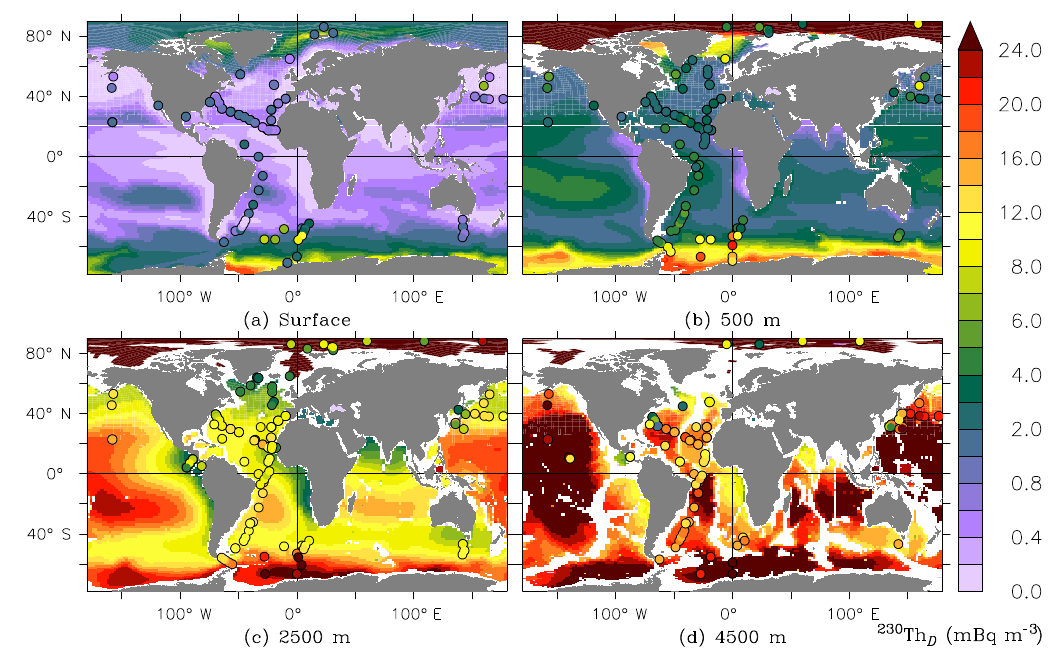
Figure 6. The dissolved thorium-230 activity at four depth levels (mBqm − 3 ); observations as discs on the same colour scale.